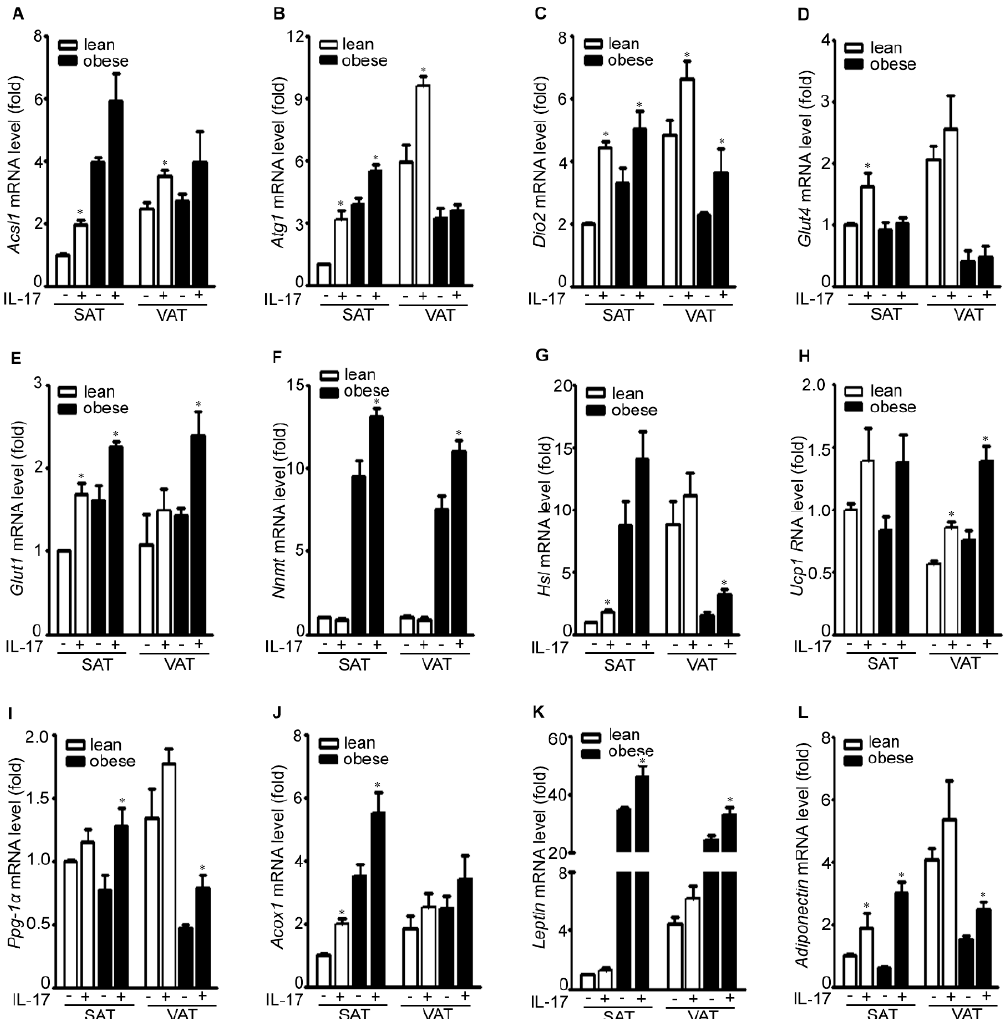
Figure 3. IL-17A differentially induces metabolic gene expression in the adipose tissues of lean and obese mice. ( A – L ) Adipose tissues were cultured in serum-free DMEM and treated without ( − ) or with (+) 20 ng/mL IL-17A for 2 h; mRNA expression of each gene was analyzed with qRT-PCR; SAT without IL-17A treatment served as the basal level for comparison; data represent mean ± SEM (error bars), n = 6 per group; * p < 0.05, comparison between the untreated and IL-17A-treated groups.